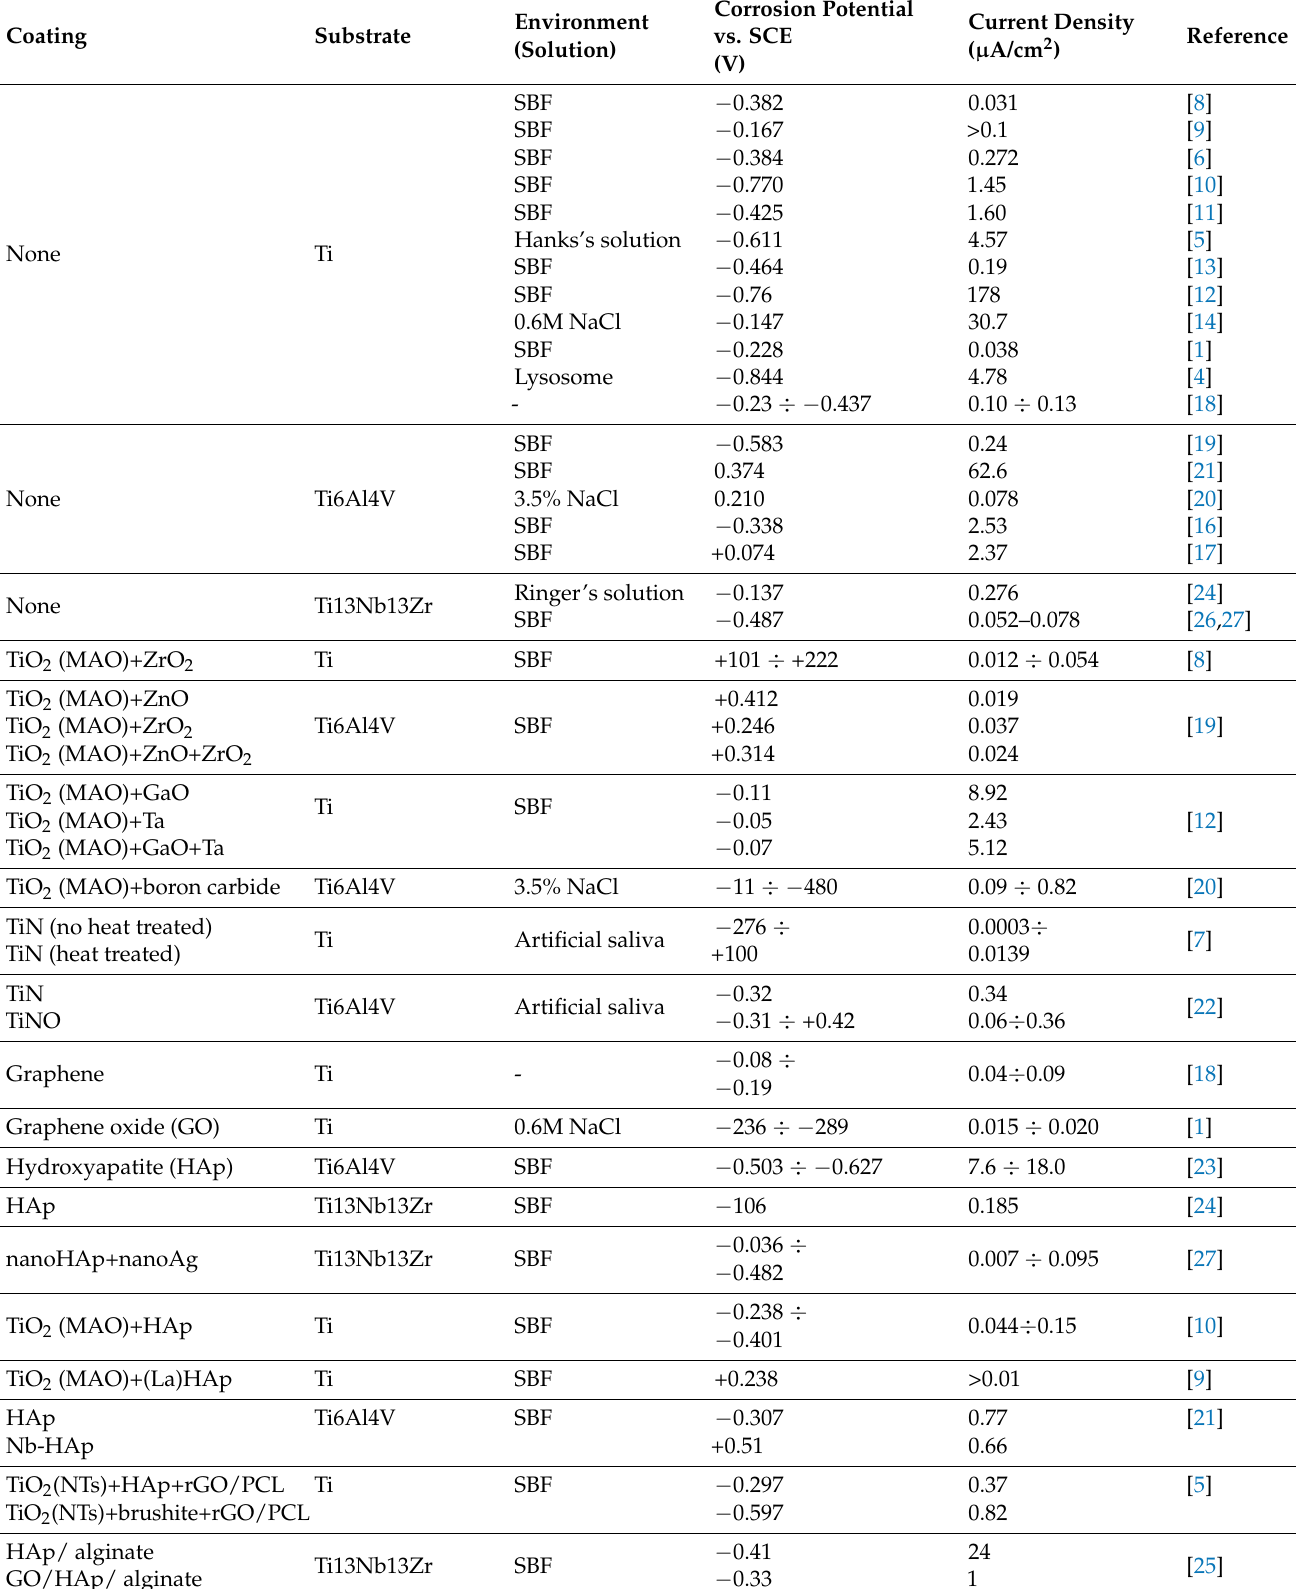
Table 1. Summary of recent results of corrosion tests published in the